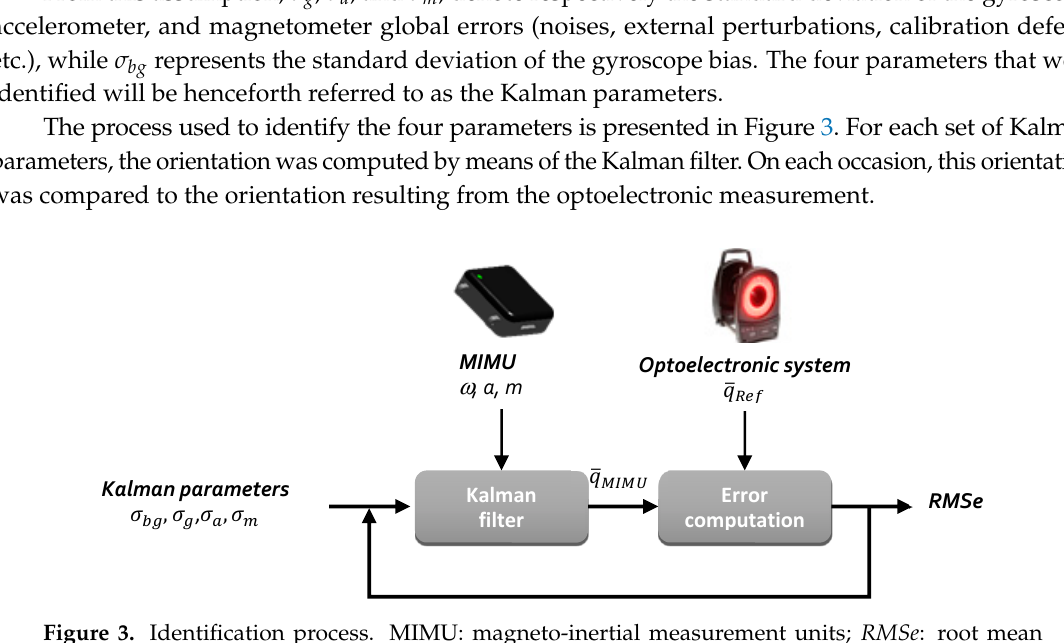
Table 2. Values of measurement noise identified by the Allan’s Variance method.